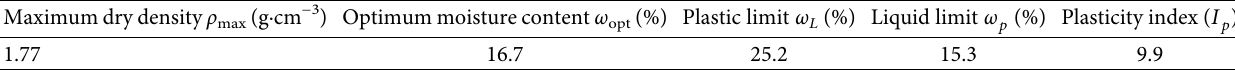
Figure 3: Particle size distribution of major Table 1: Basic physical properties of loess.